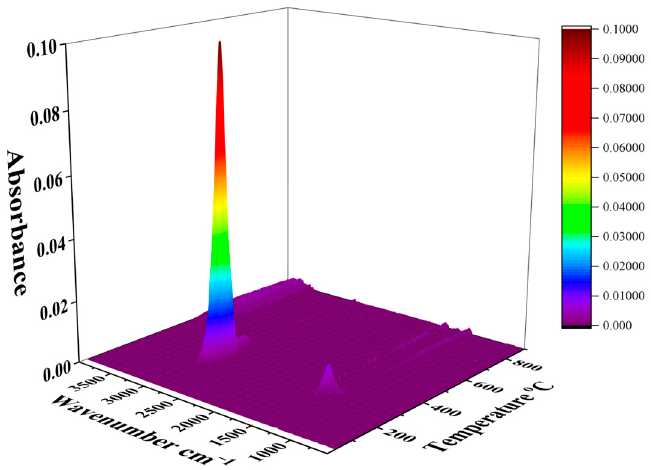
Figure 5. Three-dimensional FTIR spectra of pyrosis gas products from WEO.